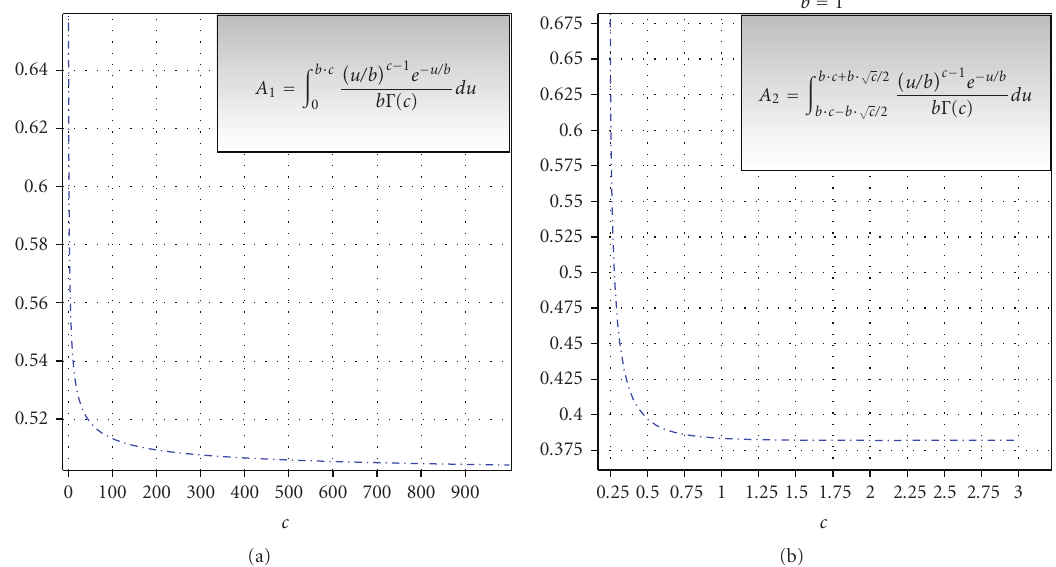
Figure 4: A 1 and A 2 curves versus c parameter. As c value increases from 0 to ∞ , A 1 reduces from 1 to 0.5, and A 2 reduces from 1 to 0.38.